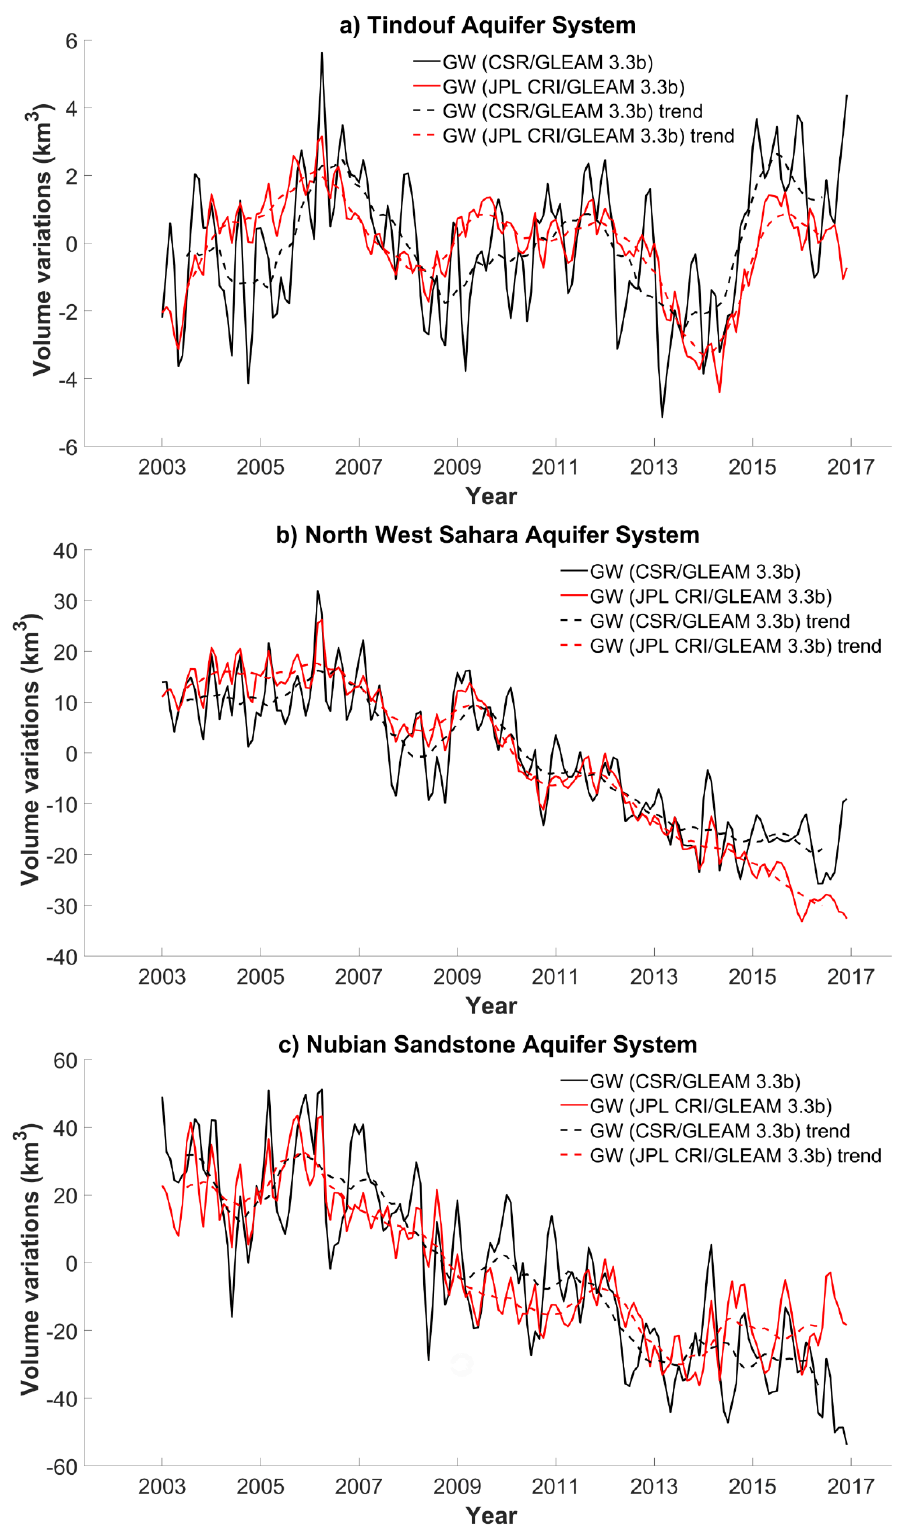
Figure 5. Time series of monthly anomalies of GWS derived from GRACE-based TWS from mascon CSR RL06, SM from GLEAM 3.3b (black), from mascon JPL CRI RL06, SM from GLEAM 3.3b (red) and associated trends (dotted lines of the same color) between 2003 and 2016 for TAS ( a ); NWSAS ( b ); and NSAS ( c ).